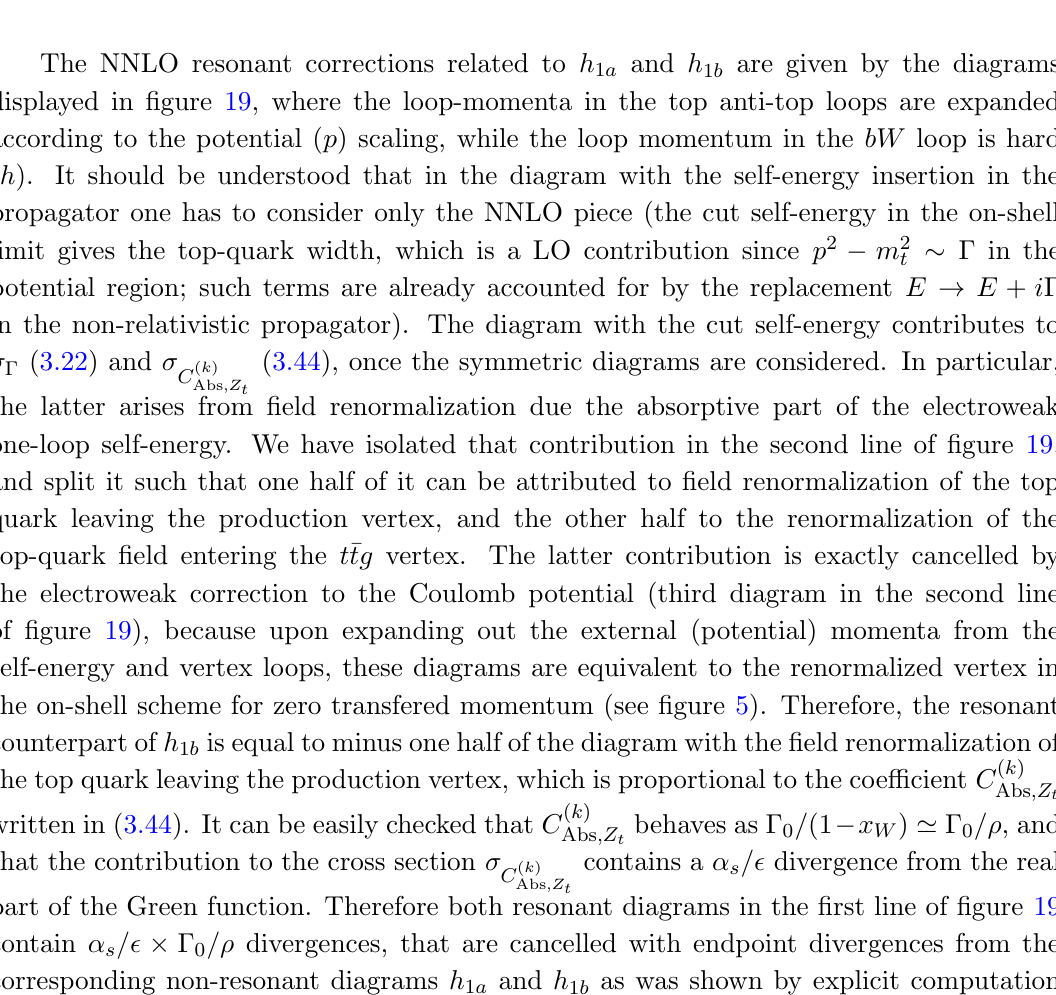
Figure 19 . Three-loop cut diagrams generating the NNLO resonant corrections related to the top-quark instability. The top anti-top loops are potential, whereas the bW top-quark self-energy is hard. The symmetric cut diagrams are not displayed. In the second line we display the terms that yield (cid:27) , and the dots stand for other resonant contributions at NNLO and higher orders. C ( k ) Abs, Zt